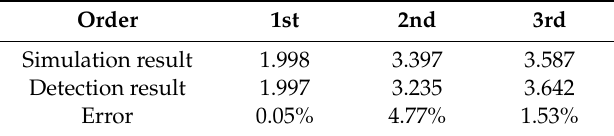
Figure 13. The vibration curve of the contact wire obtained from detection results. ( a ) Displacement of the cable in the time domain. ( b ) Corresponding frequency distribution. Table 4. The natural frequencies (Hz) of the test catenary system.